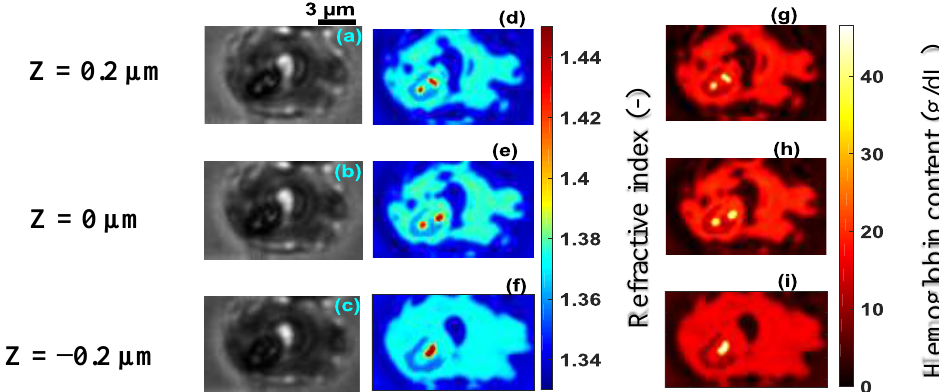
Figure 8. Recorded images of infected cell D at the schizont stage, at the wavelength λ = 800 nm for different z planes ( a )–( c ), its corresponding refractive index distribution ( d )–( f ) and hemoglobin content ( g )–( i ). The selected images are representative of a total of 33 cells analyzed.